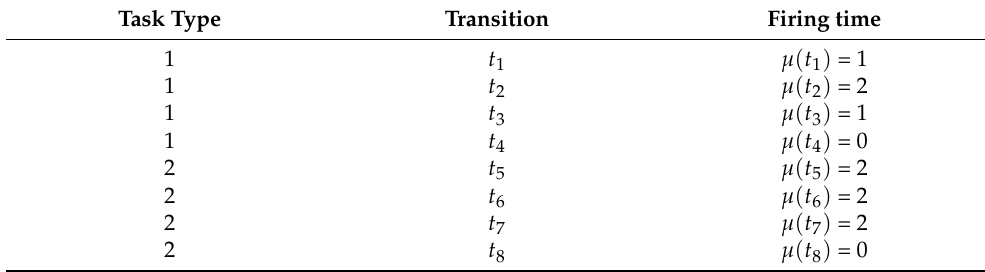
Table 2. Firing time of each transition in Figure 3a.